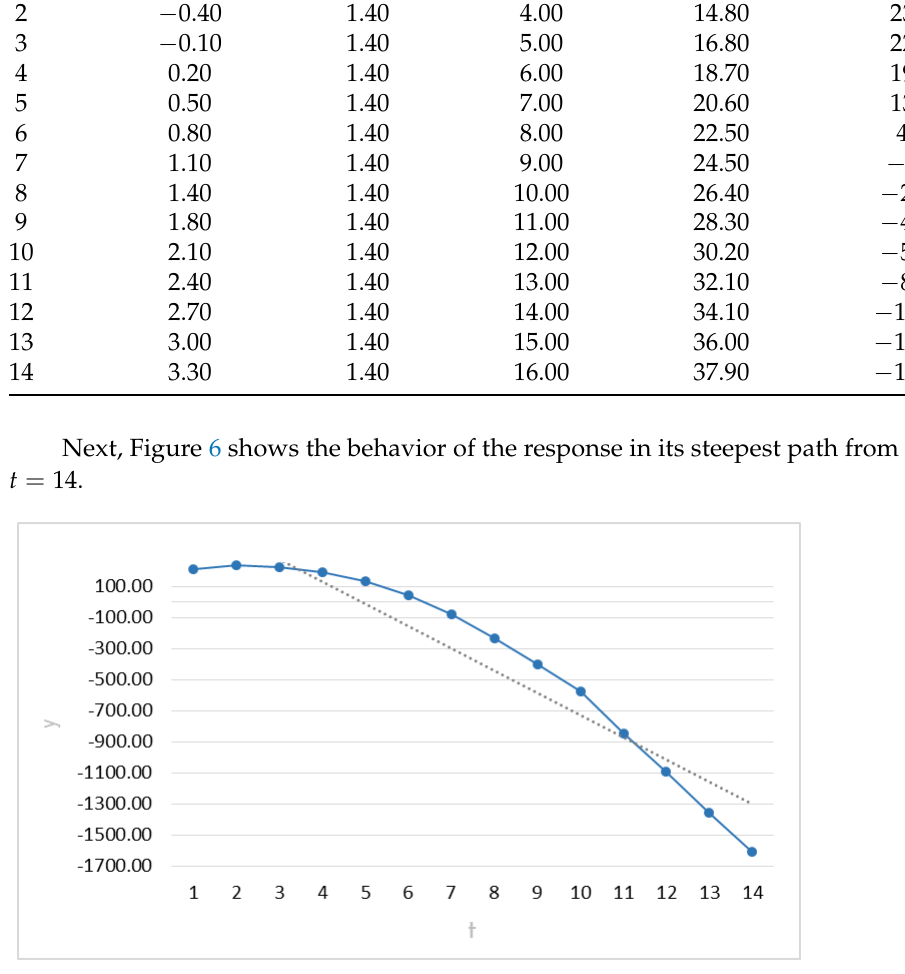
Figure 6. Graph with the steepest descent path of the response Y with a straight line, which assumes normality in Case